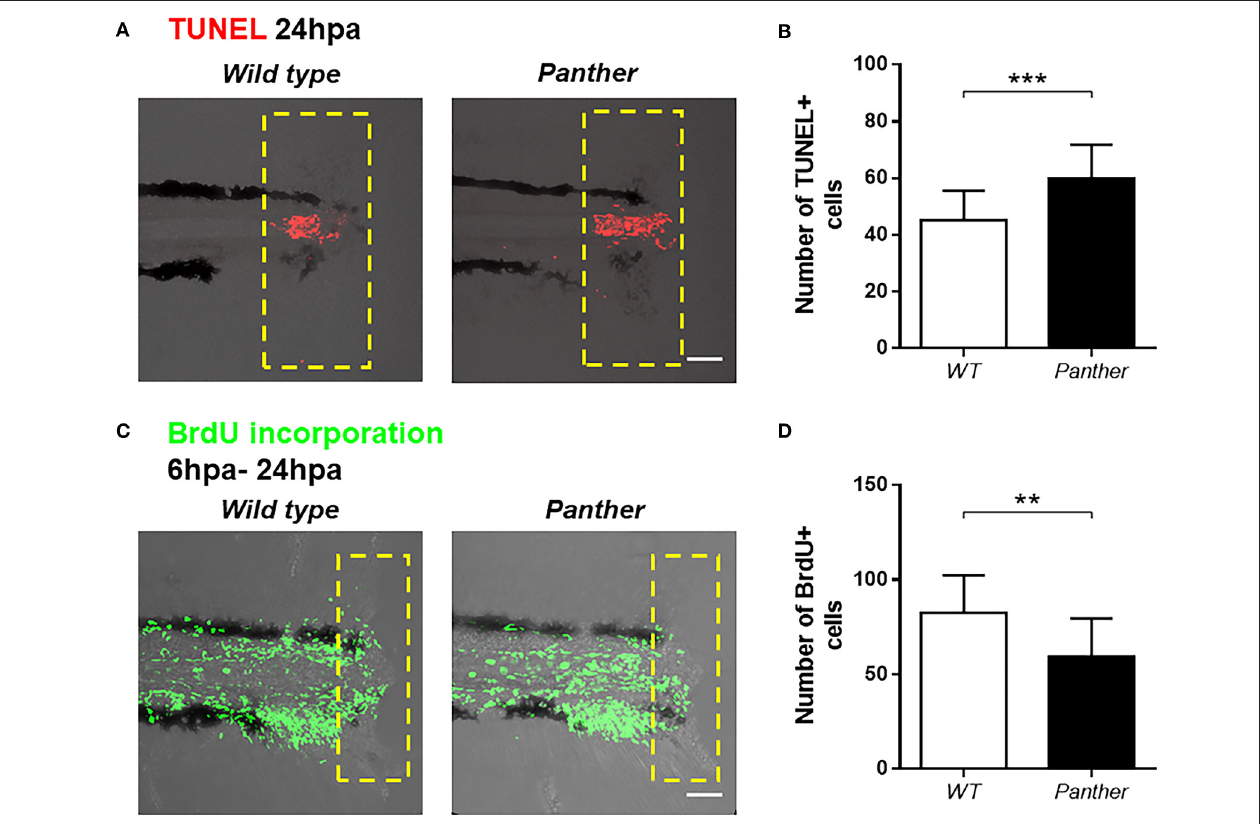
FIGURE 5 | Increased cell death and reduced cell proliferation after tail fin amputation in panther larvae. (A) Cell death was measured at 24 hpa through TUNEL assays. Red dots represent TUNEL + cells. (B) Quantification of TUNEL + cells ± SD in the damage site of panther and WT larvae at 24 hpa. Twenty larvae per condition were used. (C) Cell proliferation was assessed by BrdU incorporation from 6 to 24 hpa. Green dots represent BrdU + cells (D) The number of BrdU + cells ± SD in panther and WT individuals was obtained from 12 larvae per condition. ** p < 0.01; *** p <